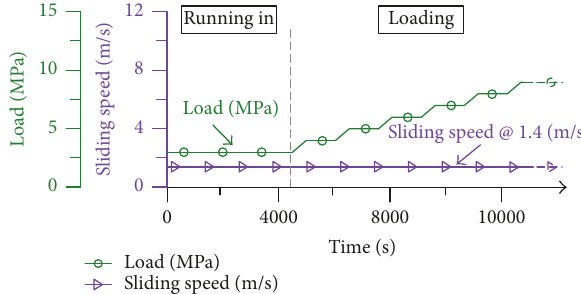
Figure 4: Input parameters of the seizure load limit test performed with the RoD test setting.